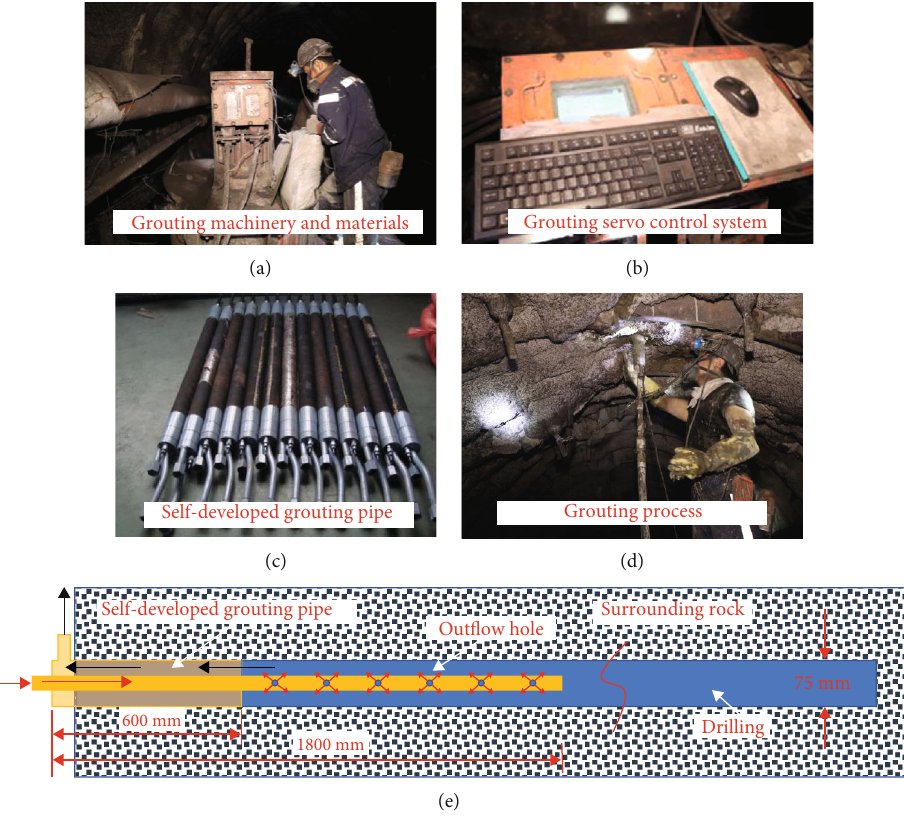
Figure 9: On-site grouting process and a newly developed grouting pipe installation method.